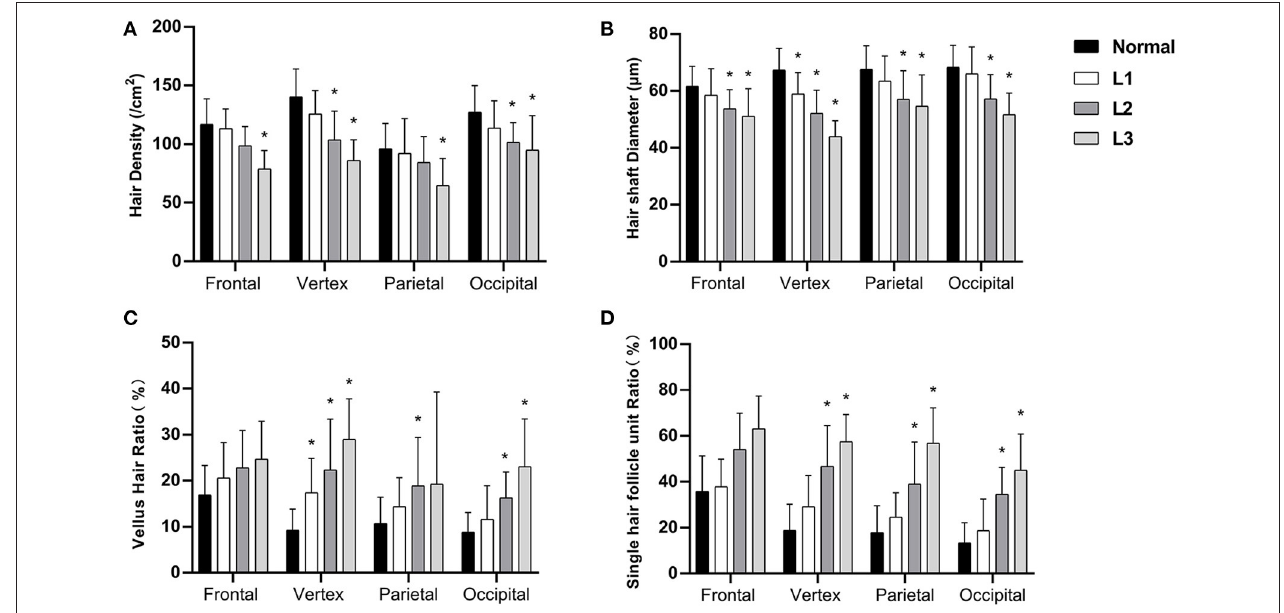
FIGURE 3 | Hair density (A) , hair shaft diameter (B) , vellus hair ratio (C) , and single hair follicle unit ratio (D) of FPHL patients from Ludwig L1 to L3. * p < 0.05 compared with normal subjects. units, followed by single hair follicle units and 3-hair